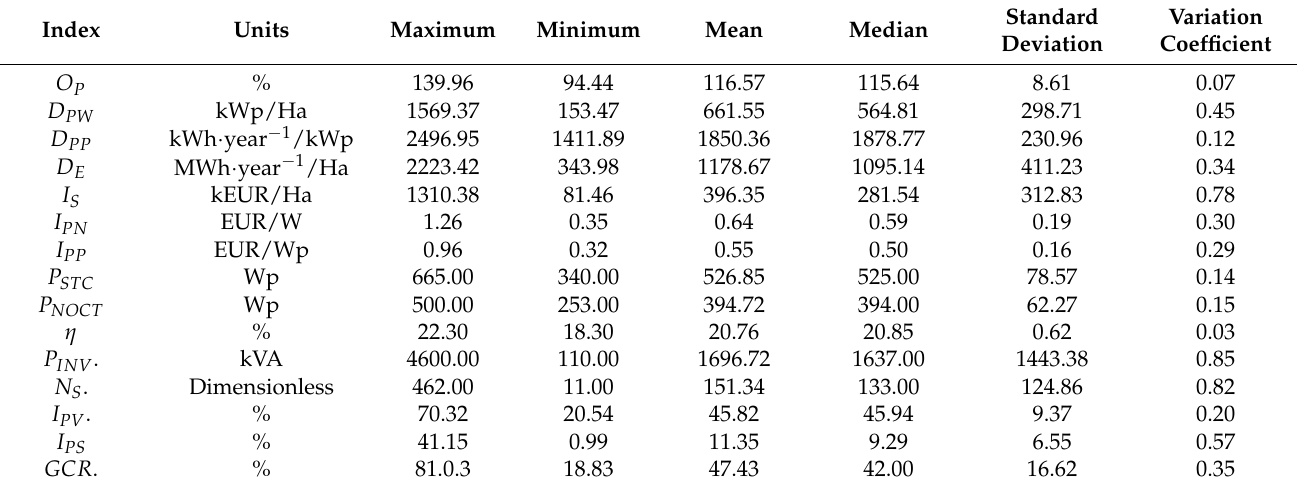
Table 3. Characteristic statistical values of each of the calculated